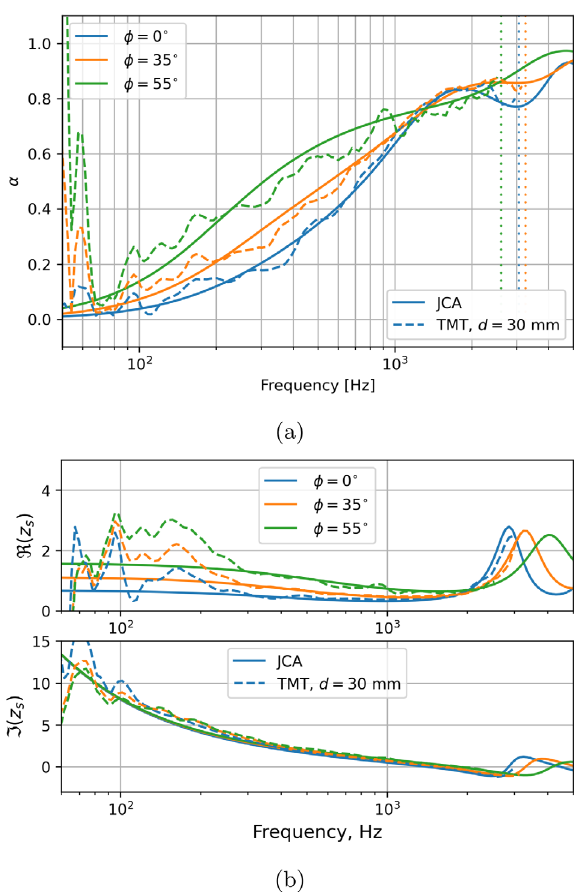
Figure 13. Absorption coef fi cient a (a), normalized surface impedance z s (b), for the con fi guration shown in Figure 2 for three incidence angles with a = 105 cm, b = 33 cm, D m (cid:7) 6.6 cm, k = 10 (cid:3) 7 , z a = 0.5